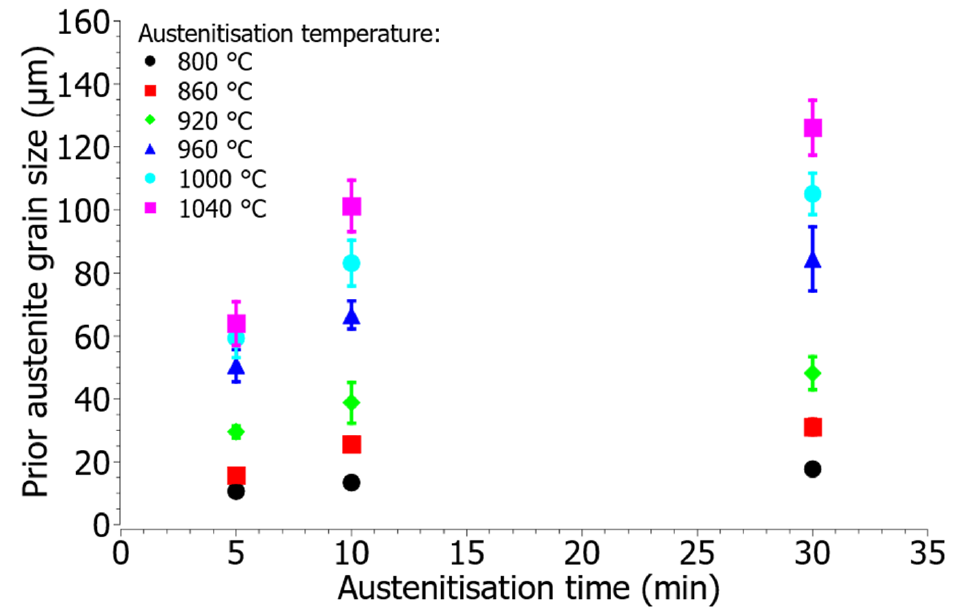
Figure 7. The size of the prior austenite grains.